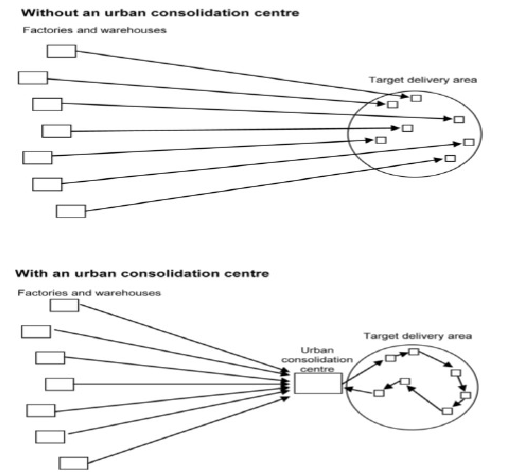
Figure 1. Conventional distribution (without consolidation) versus distribution from urban consolidation center, adopted from Allen et al., (2014)